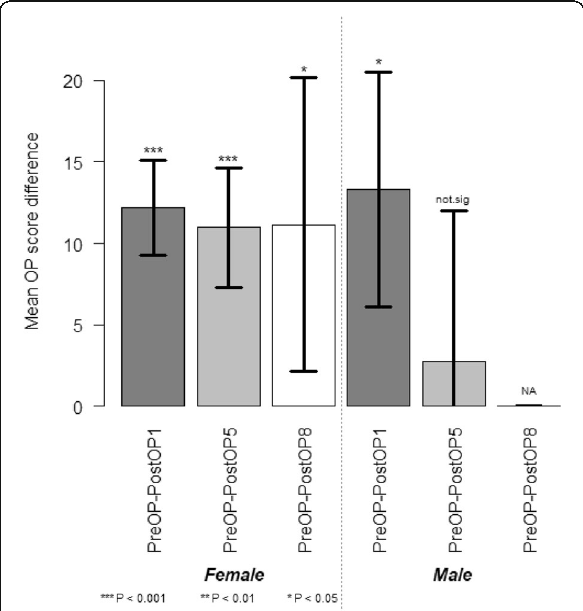
Fig. 2 Mean OKS difference 1,5 and 8 year(s) after operation among males and females